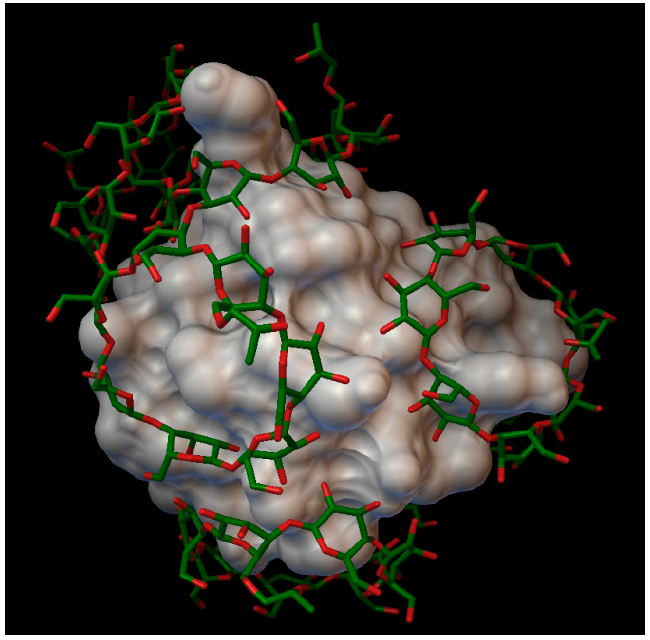
Figure 8. Insulin-hydroxypropyl- β -cyclodextrin (DS 1) complex. The insulin molecular surface is marked in white and the cyclodextrin molecules are marked with green and red licorice.